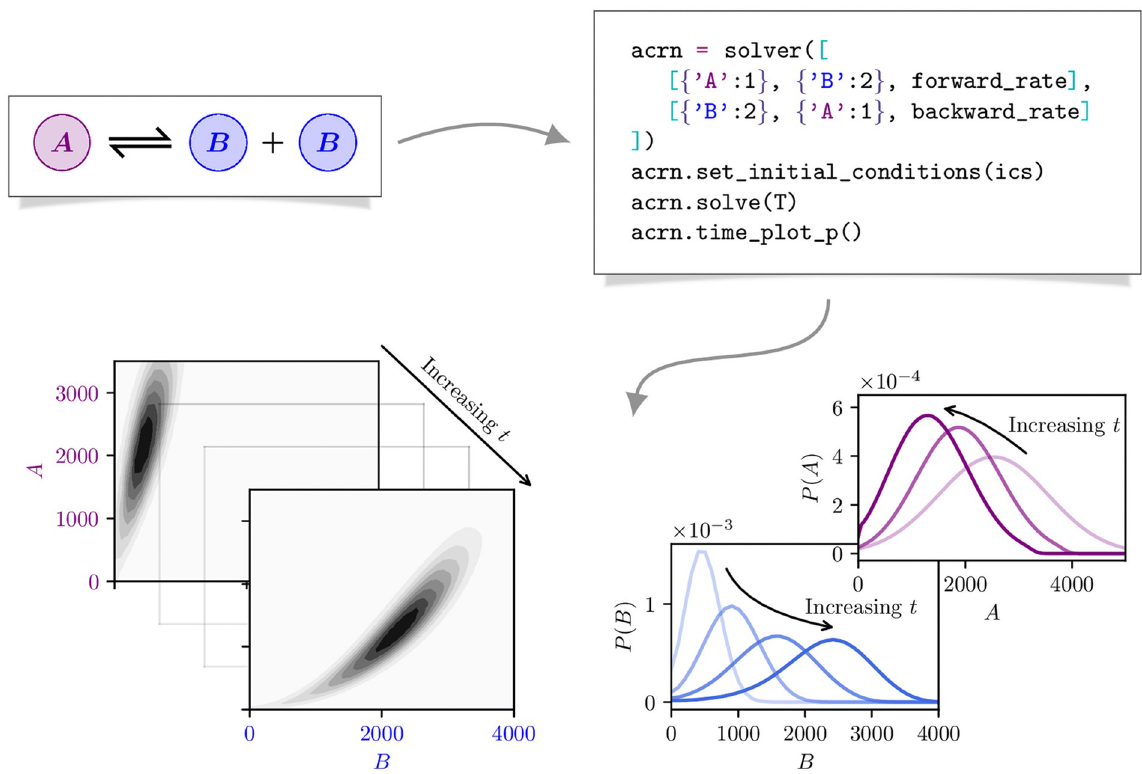
Fig 2. Schematic depiction of the Flips solver pipeline. Beginning with a (possibly augmented) chemical reaction network, we encode the reactions, set the initial distribution, and instruct the solver to determine the state distribution up to a terminal time t = T or terminal event. We may then plot the evolution of the state distribution, and its marginals, over time. For the sake of clarity, at this point we illustrate a classical chemical reaction network to highlight the simple one-to-one encoding of the reaction network, and the flavour of results the solver generates. The abstract and non-physical augmentation that distinguishes the ACME framework is demonstrated on more substantial networks in the Applications section.